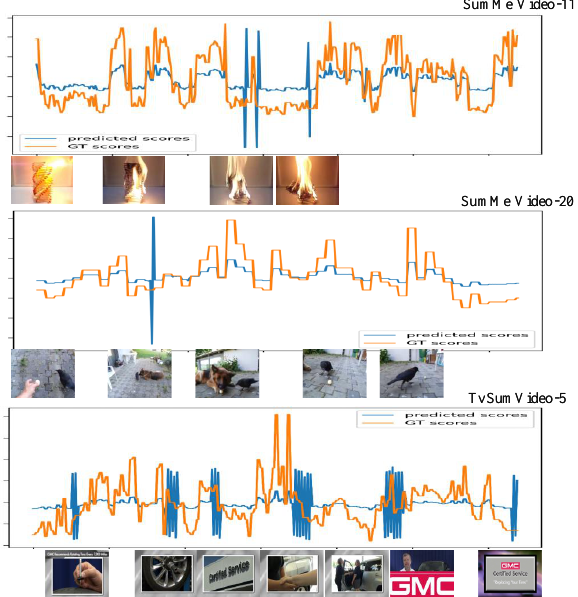
Figure 7. An example of generating video summarization on SumMe and TVSum datasets; the first two are samples from SumMe datasets and the last one is from TVSum datasets. The yellow lines show the annotation importance scores of ground truth summarization marked by the user, and the blue lines show the prediction score of our